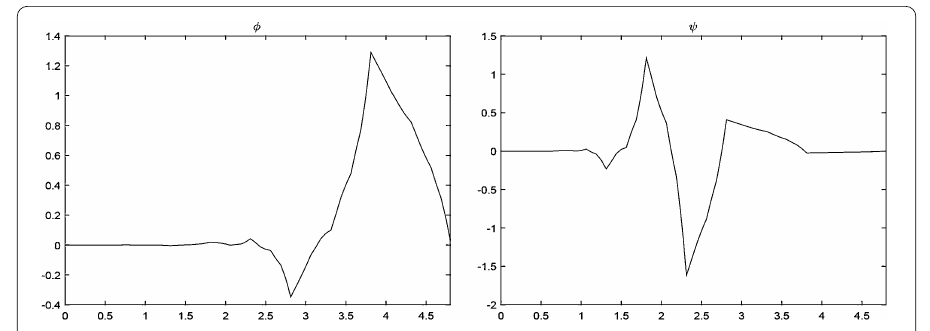
Figure 3 φ ( x ) and ψ ( x ) from Example